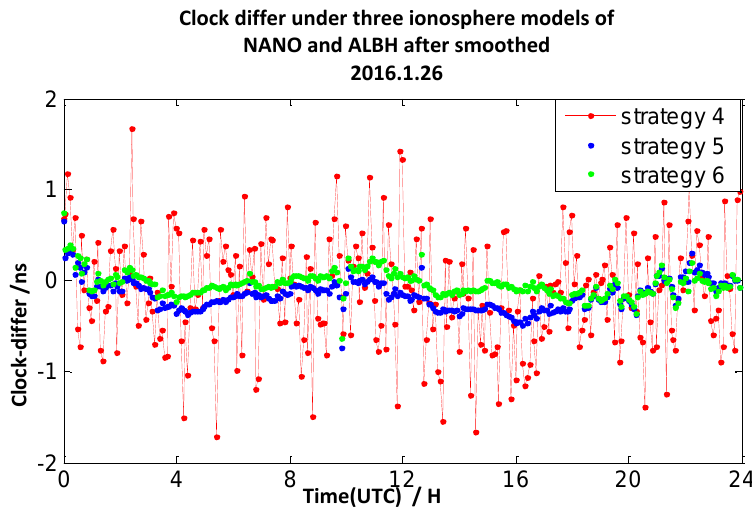
Figure 17. The clock difference under three ionosphere models of NANO and ALBH after being smoothed.